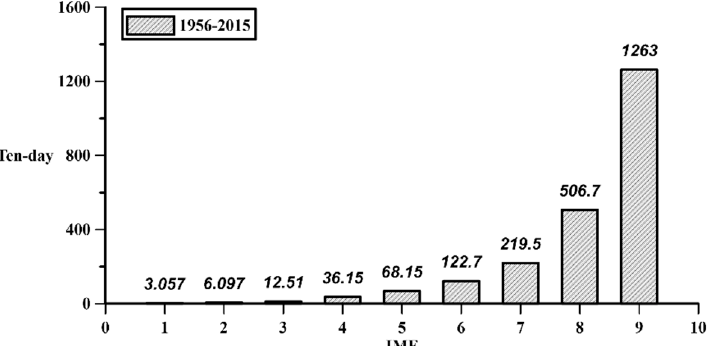
Figure 10. Average period of each IMF for a 60-year flow.